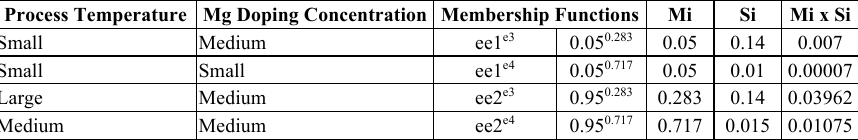
Table 3. Calculations Using MAMDANI’s Model for Rod Diameter